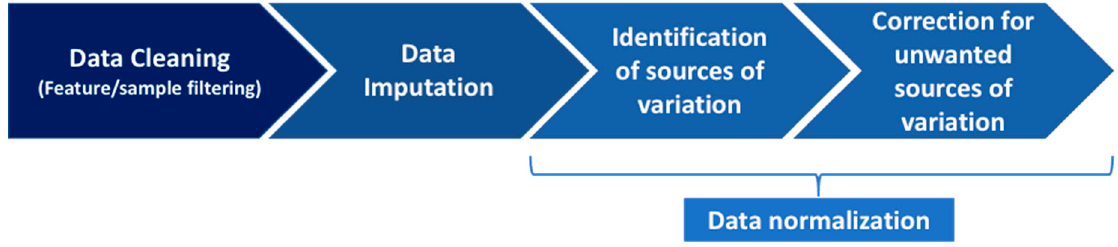
Figure 7. Main steps of the pipeline.